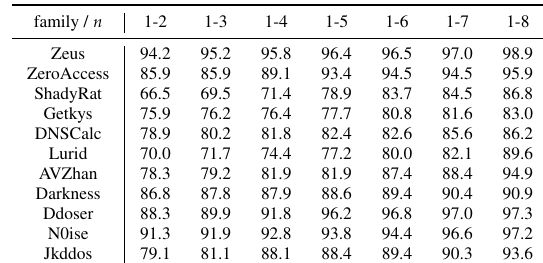
Table 6. Accuracy of classifying malware families with varying n values with recursive feature